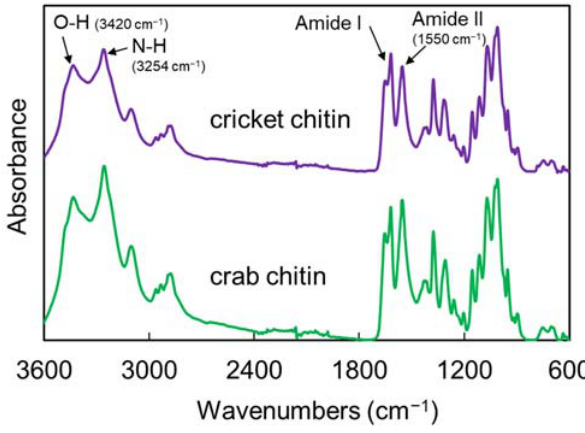
Figure 3. FT ‐ IR spectra of cricket chitin crab chitin.